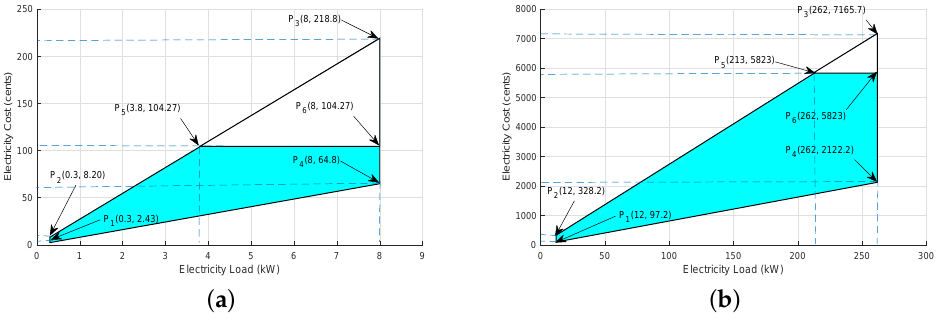
Figure 4. Feasible region for cost and electricity consumption using RTP. ( a ) Feasible region for a single home; ( b ) feasible region for multiple